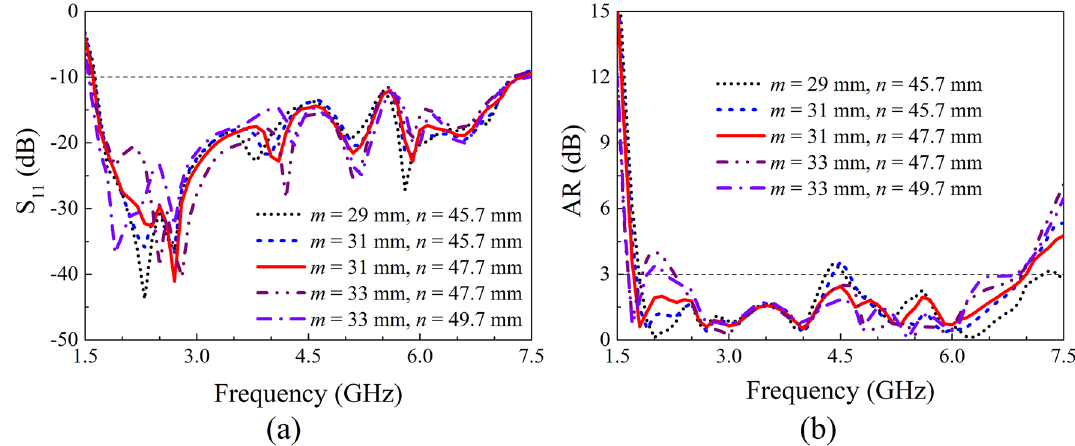
Figure 7. Effect of different m and n on S 11 and AR, respectively. ( a ) S 11 , ( b ) AR.